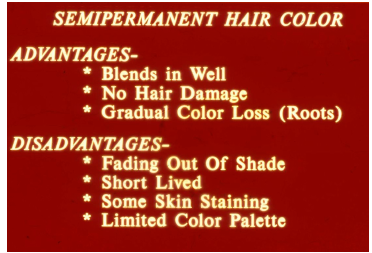
Figure 14. Rudimentary elements of semipermanent hair color.